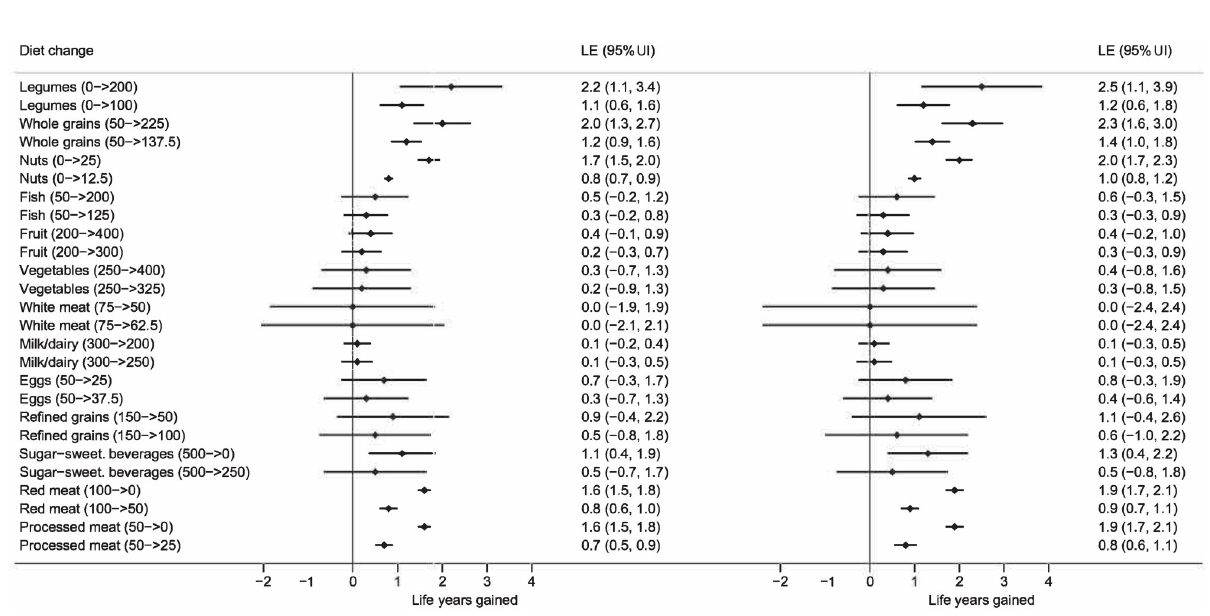
Fig 1. Expected life years gained for 20-year-old female adults (left forest plot) and males (right forest plot) from the United States who change from a typical Western diet to an optimized or feasible approach diet with changes indicated in grams per day. Estimates per food groups and total change in LE is presented with uncertainty intervals (UI). � The meta-evidence is high for whole grains; moderate for fish, nuts, legumes, processed and red meat, and sugar-sweetened beverages; and low for and very low for white meat. LE, life expectancy; 95% UI, 95% uncertainty interval.